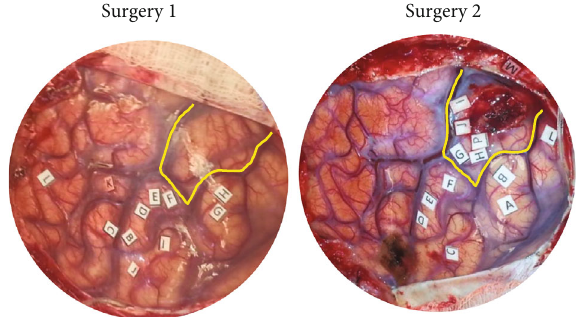
Figure 3: Plasticity, near recruitment. The yellow box highlights the same cortical area overlying the tumor. At the fi rst surgery, there is no functional activation in this area. At the second surgery, both motor and sensory functions are recruited into this perilesional cortical area (Points G-J, P). This is a prototype of near recruitment